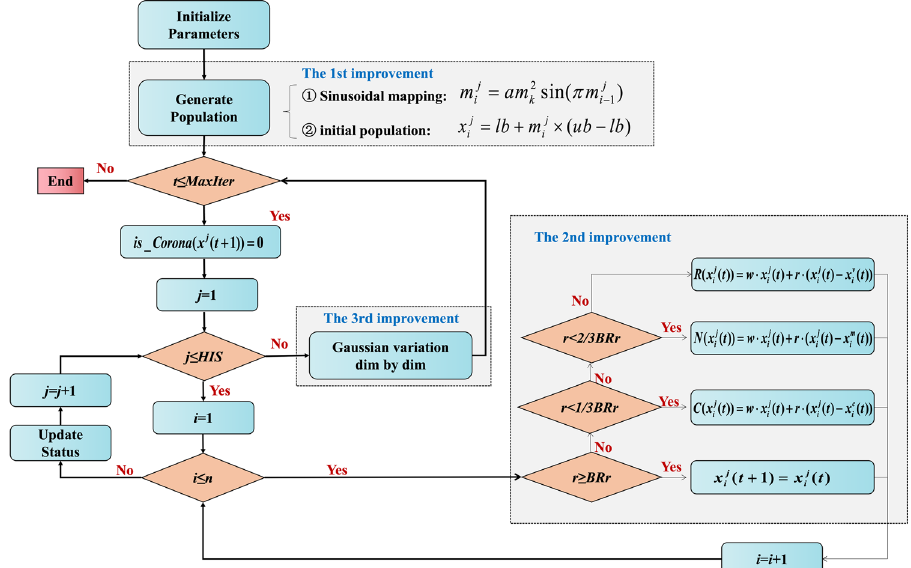
Fig. 11 Principle of the ICHIO algorithm. The fi gure shows the order of operations of ICHIO, where the shaded box corresponds to the improvement compared to the baseline